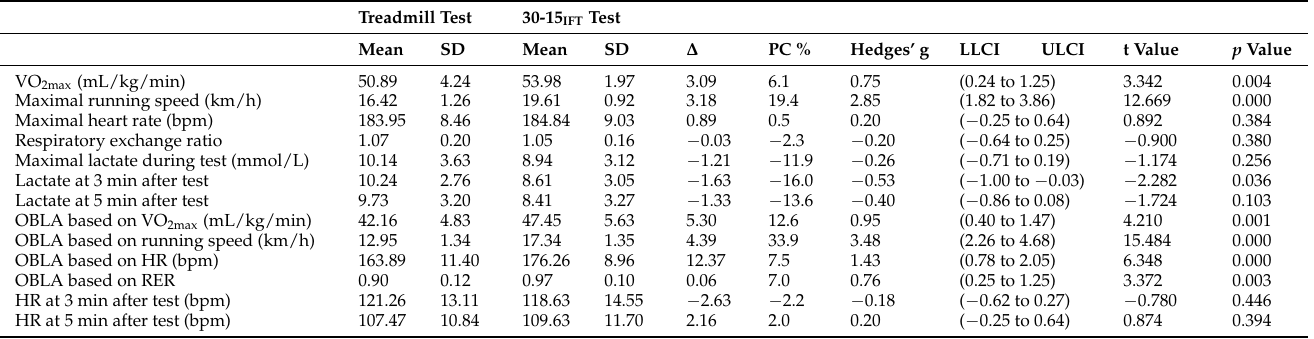
Table 1. Comparison of main physiological parameters obtained during continuous treadmill test and 30-15 IFT